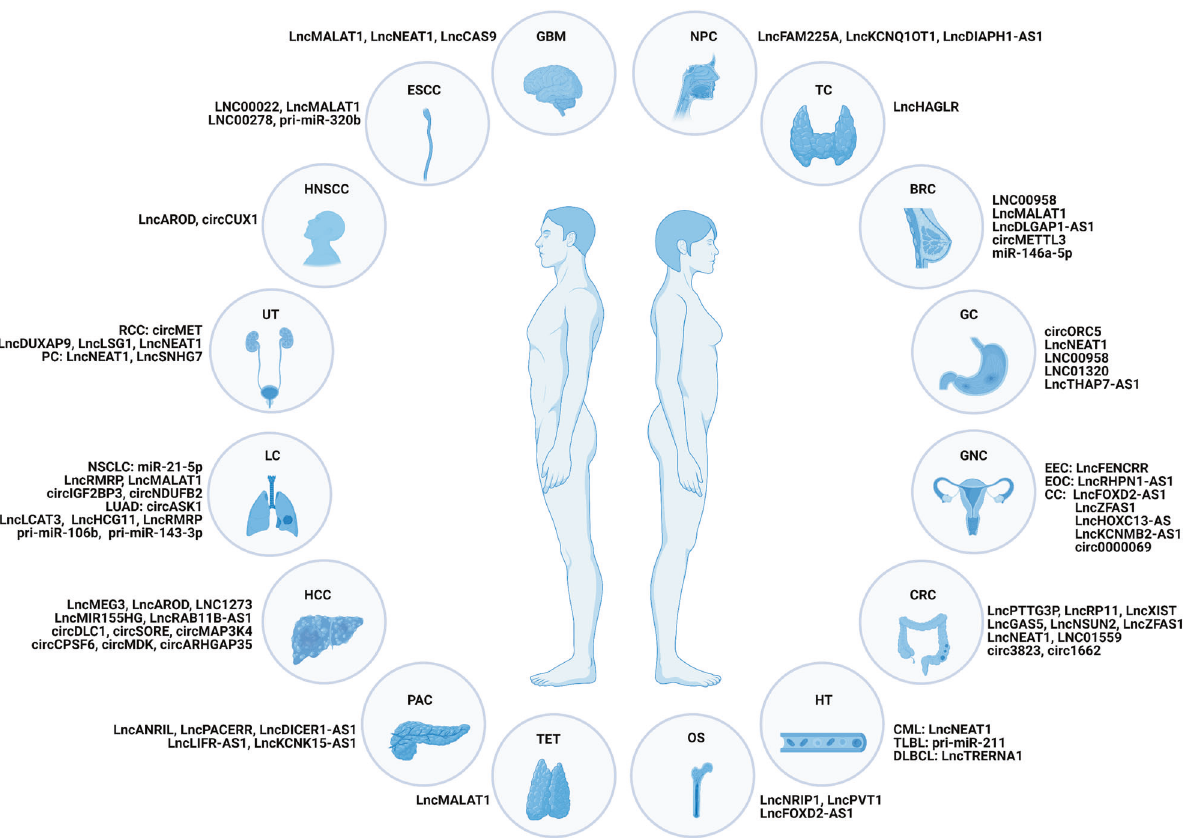
Fig. 3 Dysregulation of m6A-modi fi ed ncRNAs in human cancer. GBM glioblastoma multiforme, ESCC esophageal squamous cell carcinoma, LSCC laryngeal squamous cell carcinoma, HNSCC head and neck squamous cell carcinoma, UT urinary tract, RCC renal cell carcinoma, BC bladder cancer, PC prostate cancer, LC lung cancer, NSCLC non-small cell lung cancer, LUAD lung adenocarcinoma, HCC hepatocellular carcinoma, PAC pancreatic cancer, TET thymic epithelial tumor, OS osteosarcoma, HT hematological system, CML chronic myeloid leukemia, TLBL T-cell lymphoblastic lymphoma, DLBCL diffuse large B-cell lymphoma, CRC colorectal cancer, GNC genital system, EEC endometrioid endometrial carcinoma, EOC epithelial ovarian cancer, CC cervical cancer, GC gastric cancer, BRC breast cancer, TC thyroid cancer, NPC nasopharyngeal